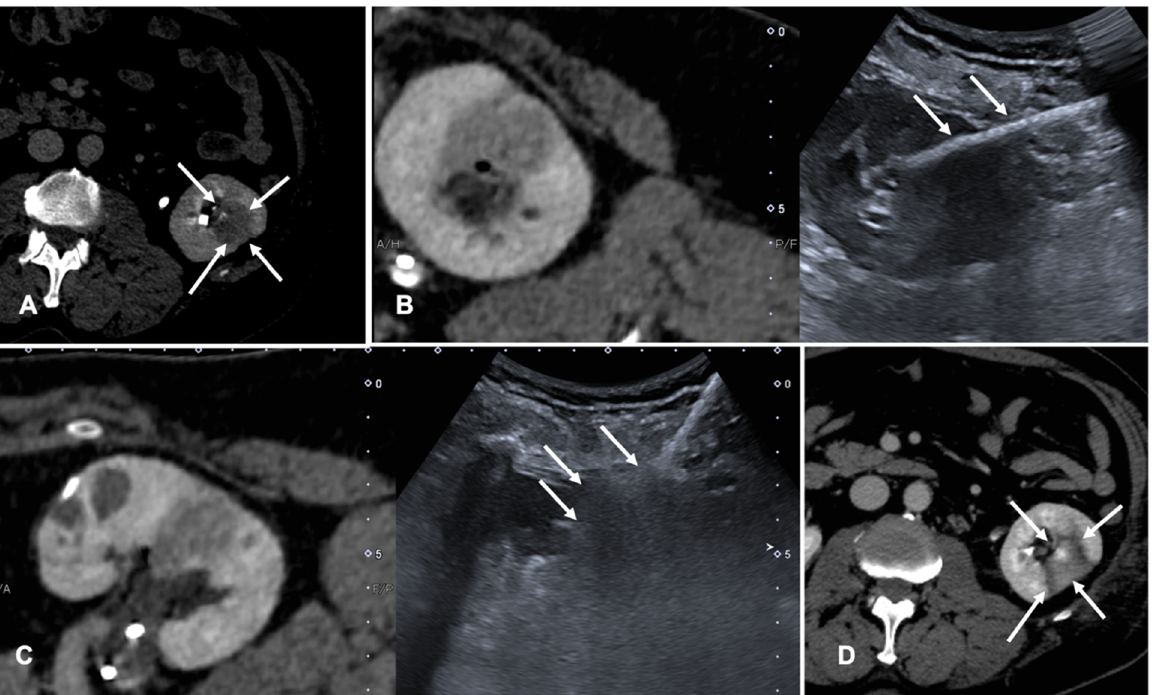
Figure 3. Case of a patient with left kidney clear cell renal cancer treated with microwave ablation (MWA). ( A ) Axial view during delayed excretory phase of the preoperative contrast enhanced Computed Tomography (CECT) showing a 25 mm intrarenal lesion (white arrows); ( B ) Fusion imaging (FI) of the same CT (left side) and intraoperative ultrasound (right side). MWA needle is marked by two solid arrows on the right. ( C ) FI during MWA of the lesion. Arrows point out the area of gas formation at the tip of the ablation needle. ( D ) An axial view of the control CT at the end of the procedure. Arrows point out the resulting completely ablated area of the kidney lesion.